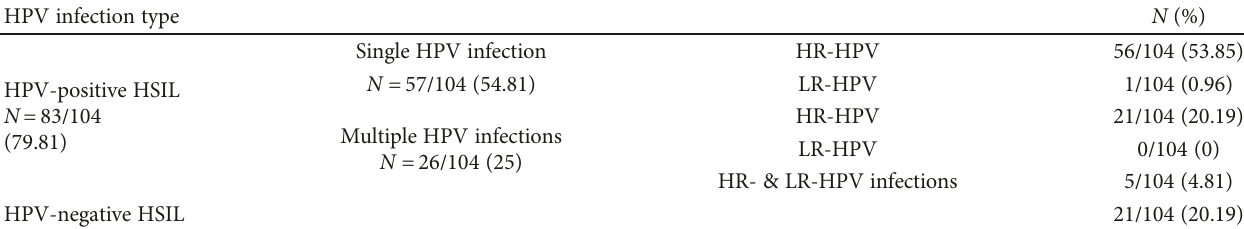
Table 2: Distribution of analyzed HSIL specimens with respect to HPV infection type (as assessed via REBA).